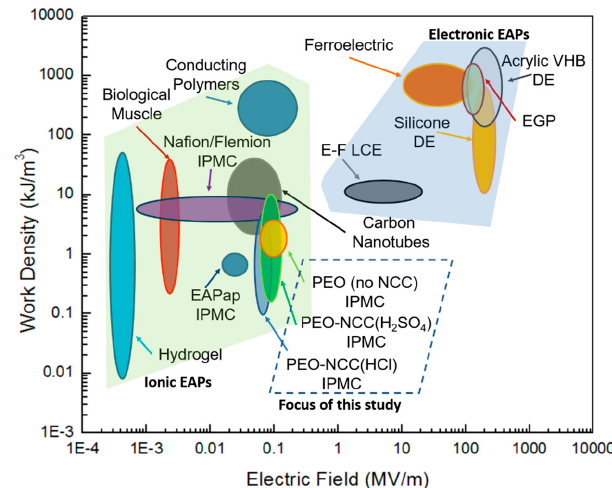
Figure 5. Electromechanical performance comparison for ionic and electronic EAPs ( i -EAP and e -EAP data generated, in part, from data posted in Madden, et al.